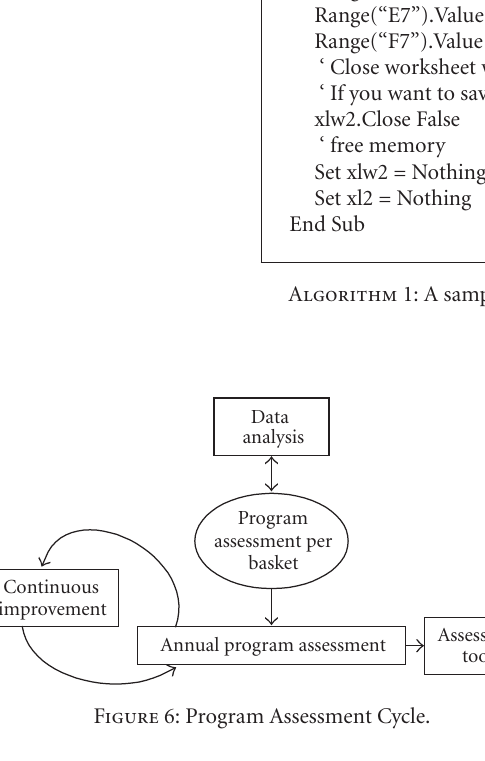
The continuous refinement to this process is thus made once feedback from each stake holder and that from ABET accreditation body is available to the